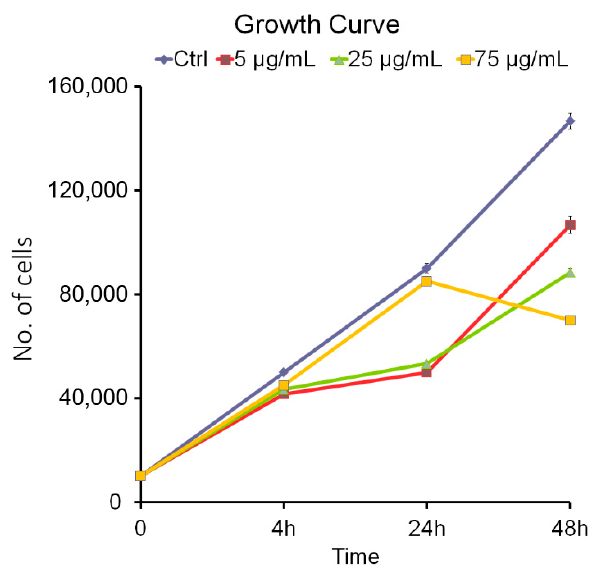
Figure 1. Growth curve in the Hs27 cells was determined by Trypan Blue (counting dye method). The effects of polystyrene nanoparticles (PNPs) exposure were evaluated following exposure at 4, 24, and 48 h at 5, 25, and 75 μ g/mL concentrations and compared to the control cells. Error bars represent the standard error of the mean.